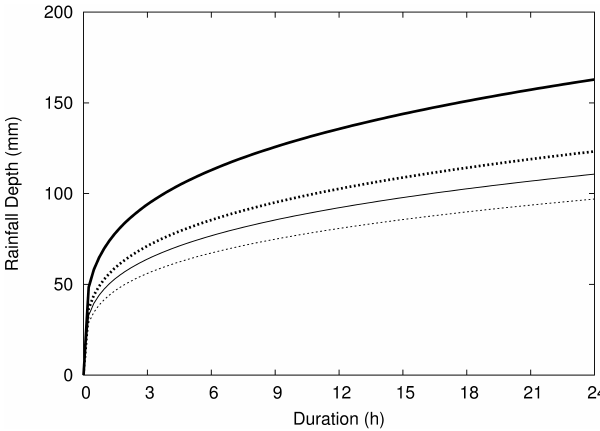
Fig. 2. Time series of rainfall annual maxima for event duration D = 24 h for the stations: CREMONA (solid line) and LODI (dot- ted line)